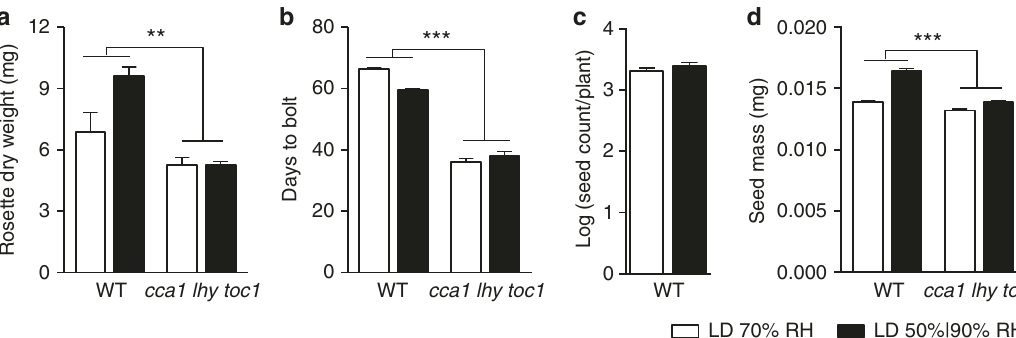
Fig. 4 Simulated natural conditions improve plant fi tness-related traits. Leaf-rosette dry weight ( a ), fl owering time ( b ), seed count ( c ) and seed mass ( d ) of plants grown under LD with either constant 70% RH (white) or simulated natural conditions (black). Data are shown as mean ± s.d. of three experimental replicates representing at least 45 plants ( a ), 75 plants ( b ), 36 plants ( c ) and 70 plants ( d ) from a single parent line. Data were combined using linear mixed effect model (lme4) with experiment as random effects; two-way ANOVA, ** p < 0.01, *** p <